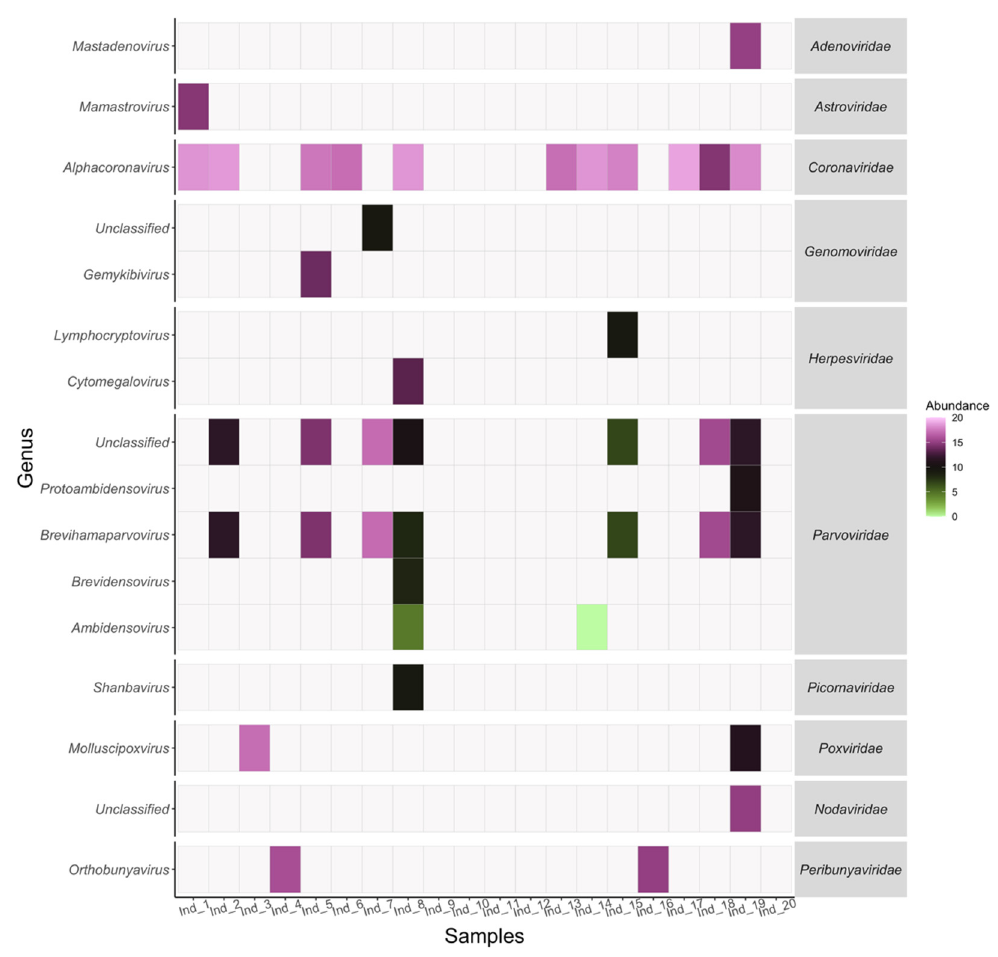
Figure 1. Virome presence and abundance. The abundance within samples is presented for genera and families in viruses with vertebrate hosts. The abundance is expressed by log2 of the reads per kilobase per million mapped reads (RPKM).